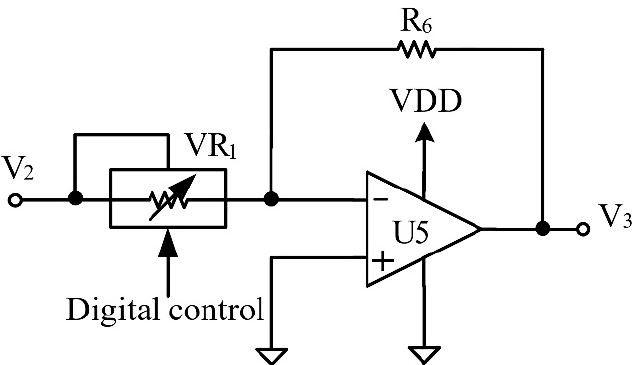
Figure 4. The implementation of the amplifier with gain control.